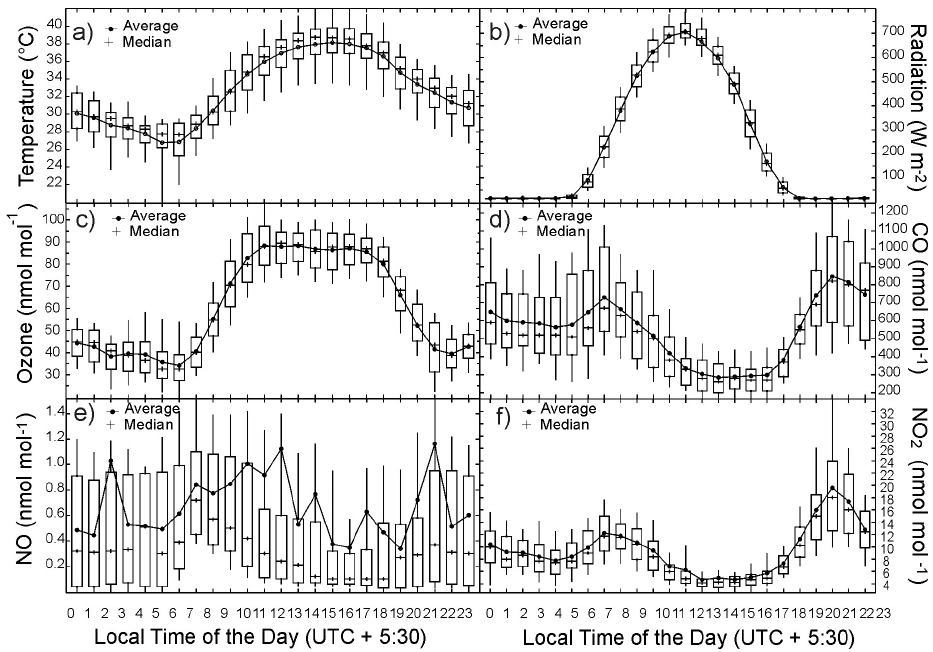
Figure 9. Diel box and whisker plot of (a) the ambient temperature, (b) radiation, (c) ozone, (d) carbon monoxide, (e) nitrogen monoxide and (f) nitrogen dioxide (refer to Section 2.2.3 for details of the NO x measurements) derived from all measurements ( n > 14300 for each species) in May 2012 at the measurement